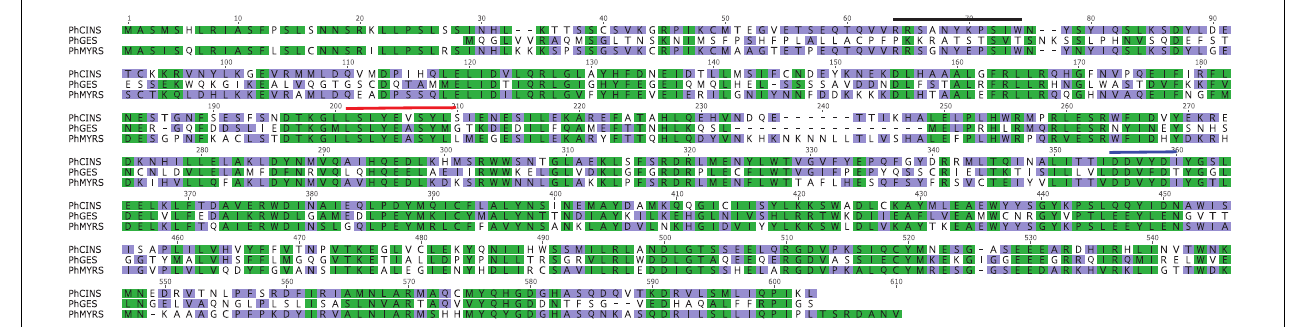
FIGURE 3 | Protein sequence alignment of the three mTPSs isolated from P. × hybridum cv. rosat ‘Grasse,’ PhCINS (MF503881), PhGES (MF503883) and PhMYRS (MF503884). Conserved amino acid regions typical of terpene synthases are overlined: motif RR(x) 8 W in black, motif LSLYEASYL in red and motif DDxxD in blue.